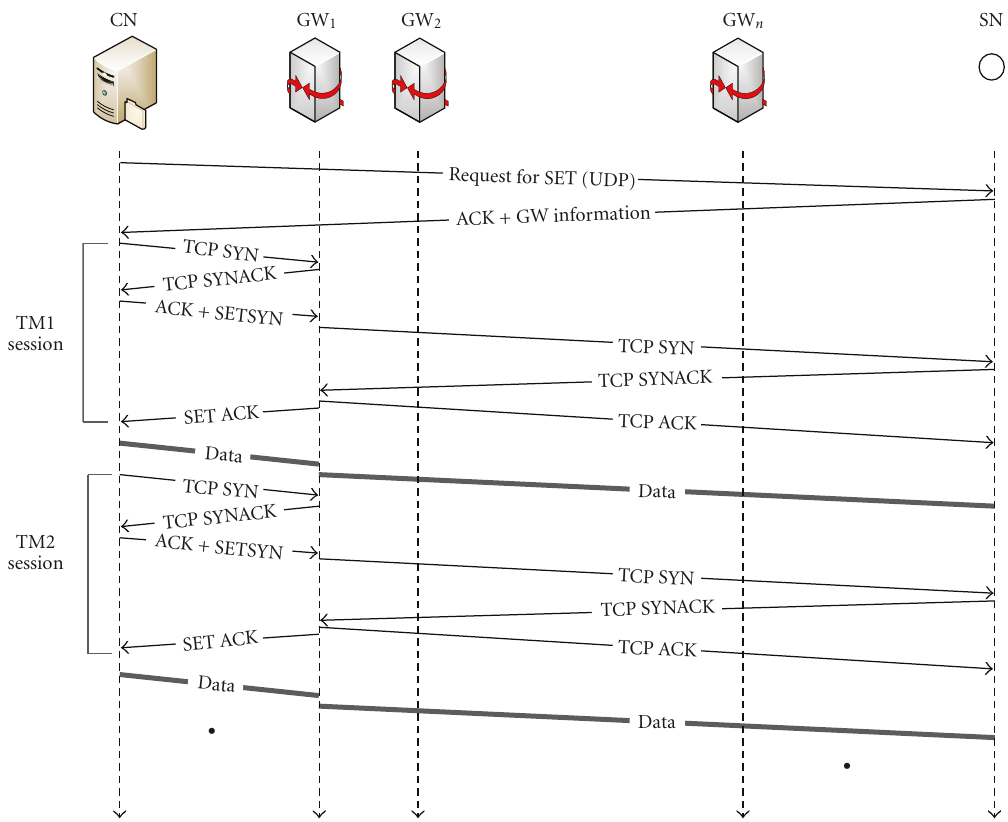
Figure 7: Timing diagram for SET connection establishment.